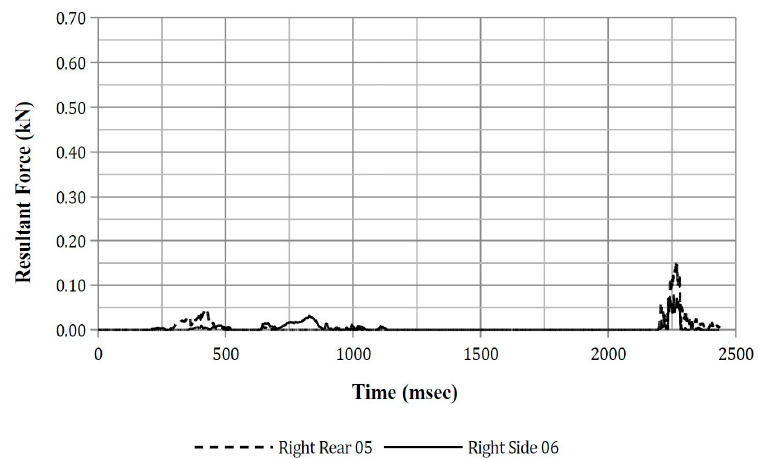
Figure A28. ATD Position 5 thorax resultant force.